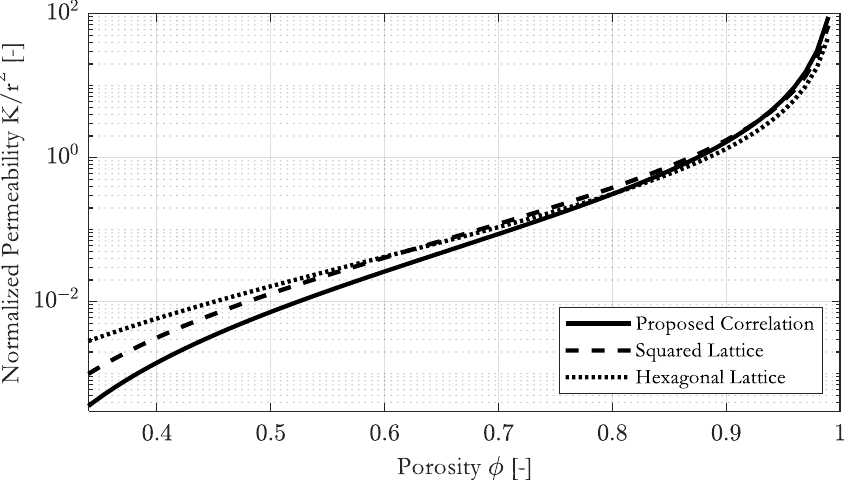
Figure 11. Comparison of the proposed correlations to correlations by Gebart [8] for a squared and a hexagonal arrangement of the fibers, to estimate the permeability of fibrous media.